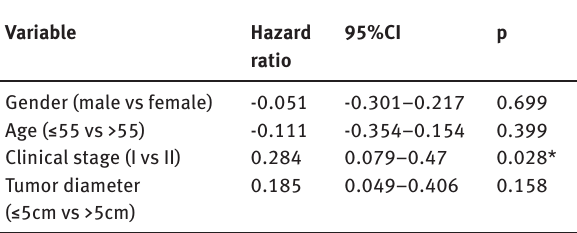
Table 3: Correlation of clinical parameters with effective outcome